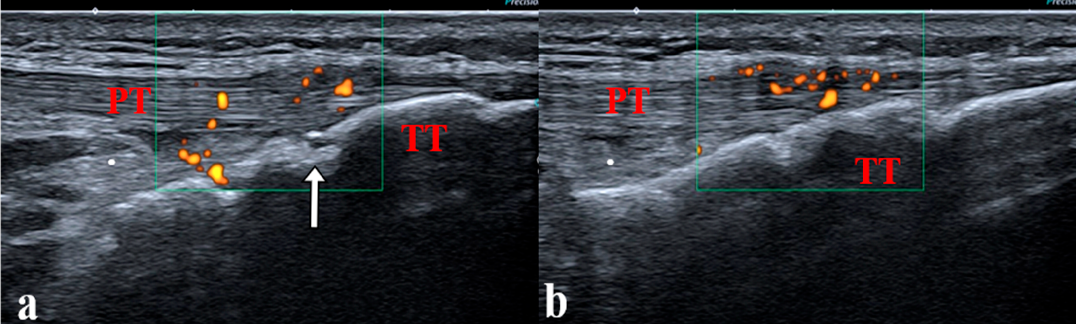
Figure 5. ( a , b ) Enthesitis of the distal patellar ligament in a 14-year-old boy with juvenile enthesitis- related arthritis. Longitudinal scan of the distal patellar ligament showing bilateral enthesitis. PT: patellar tendon; TT: tibial tuberosity; white arrow: secondary ossification center, incompletely ossified tibia.